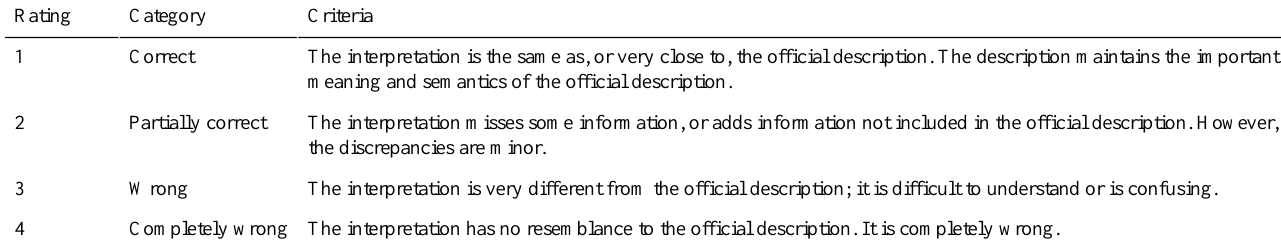
Table 1. Criteria for judging open-ended interpretations.